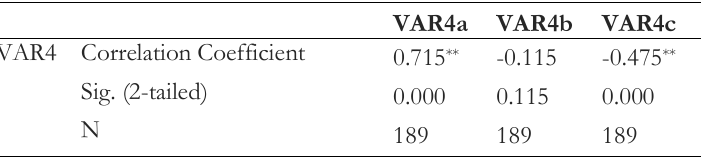
Table 8. Correlation among neutrosophic item 4 and classical item